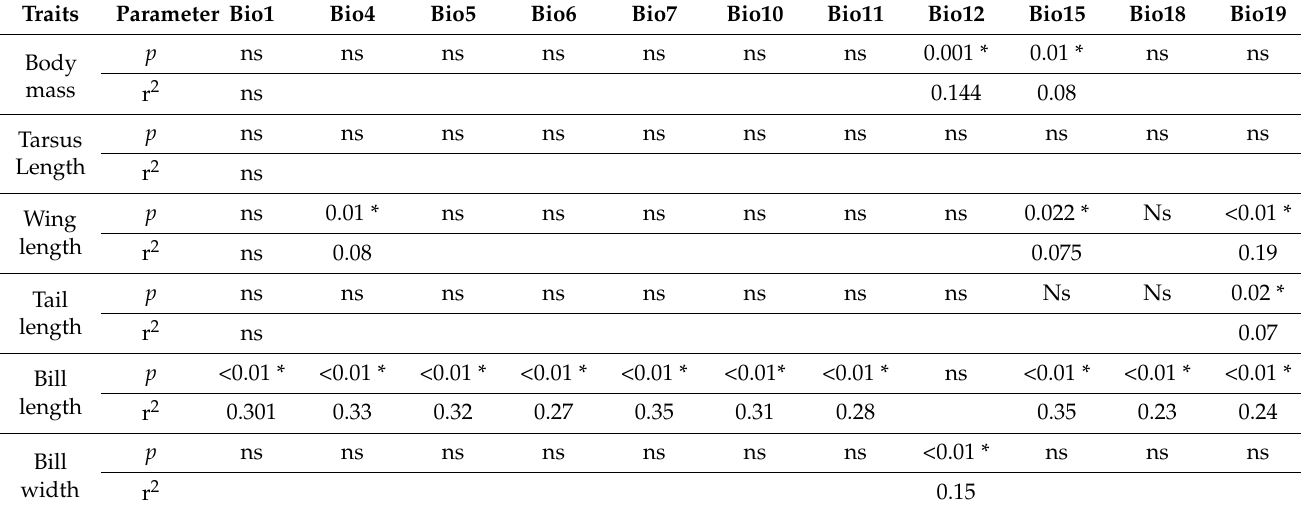
Table 2. Relationship between morphological measurements of house sparrow and bioclimatic variables.